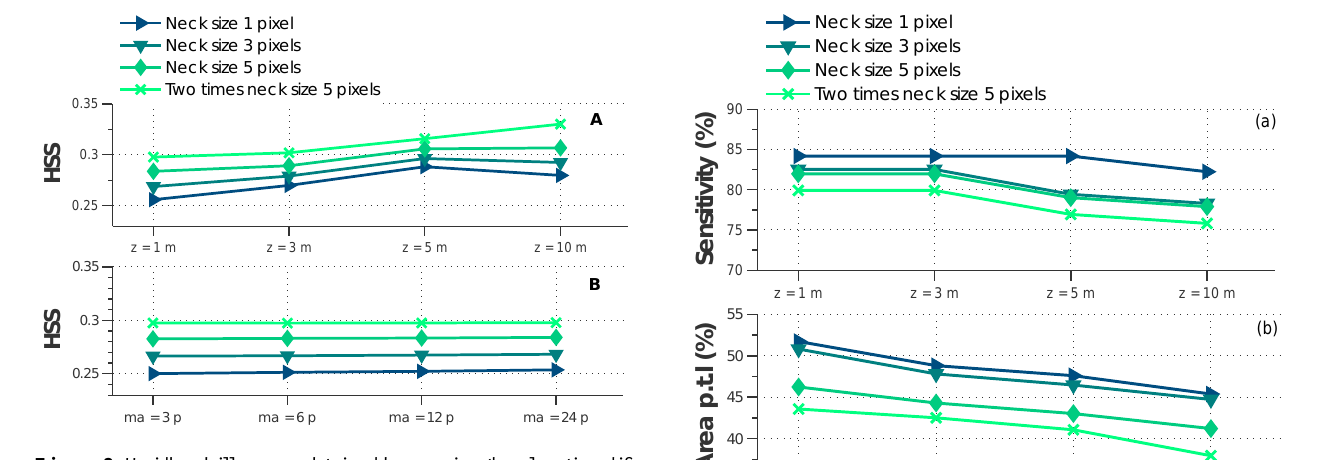
Figure 3. Heidke skill scores obtained by varying the elevation dif- ference criterion (a) , and the minimum area criterion (b) . Results are shown for four pre-filtering options (i.e., neck size). The eleva- tion difference criterion is given in meters (m), whereas the mini- mum area criterion in number of pixels (p).